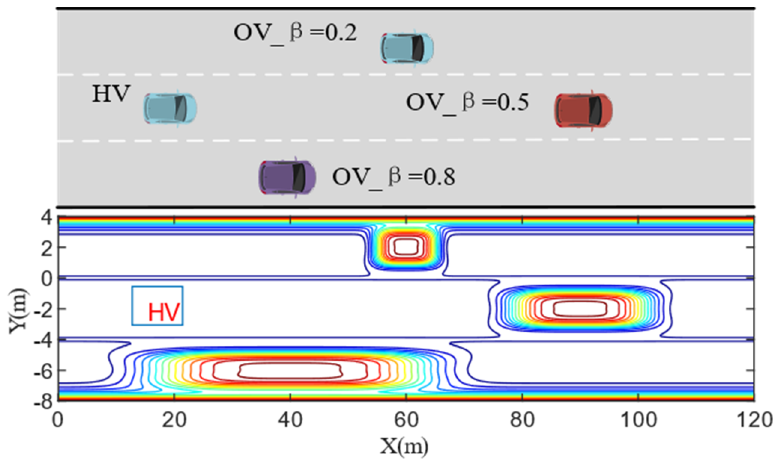
Figure 7. Contour distribution of HV’s driving risk field in the example scenario.